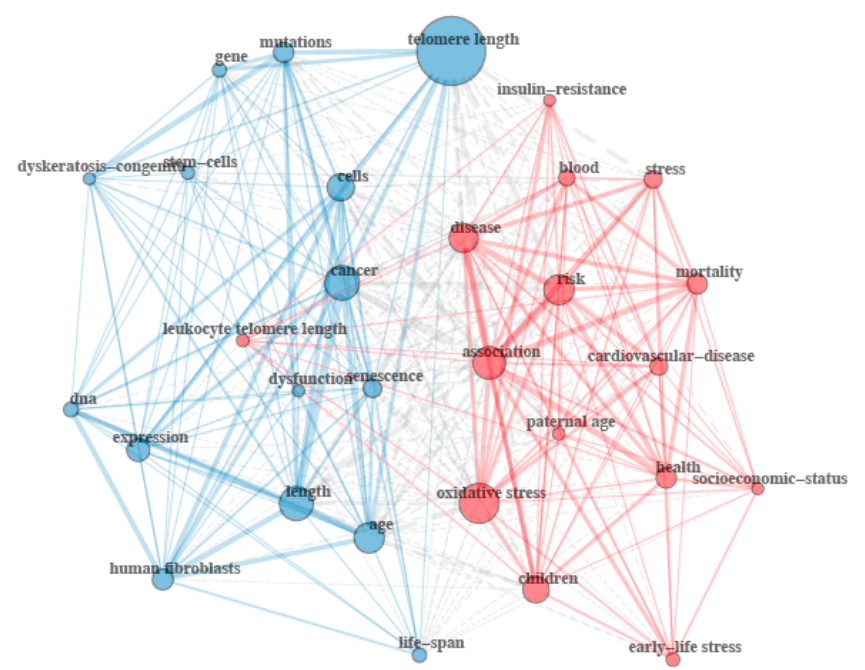
Figure 6. Keyword plus terms co-occurrences network map.